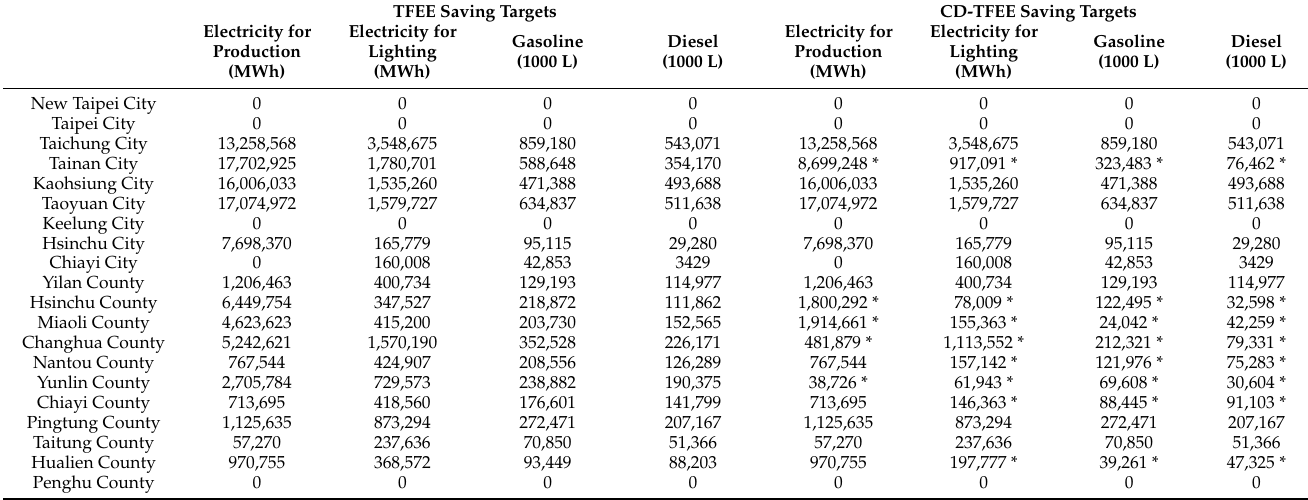
Table 8. Energy saving targets obtained from CD-TFEE and TFEE models. TFEE Saving Targets CD-TFEE Saving Targets Electricity